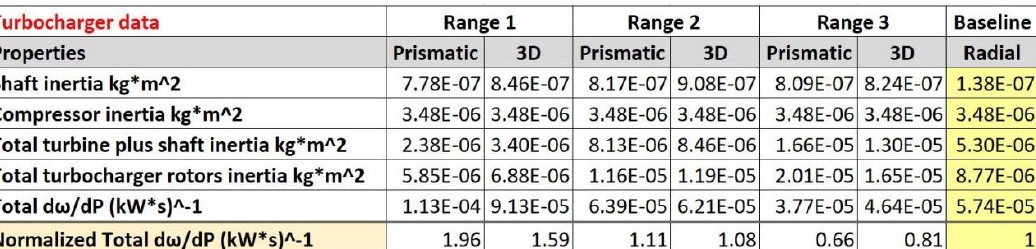
Table 3. Overall turbocharger rotor performance.